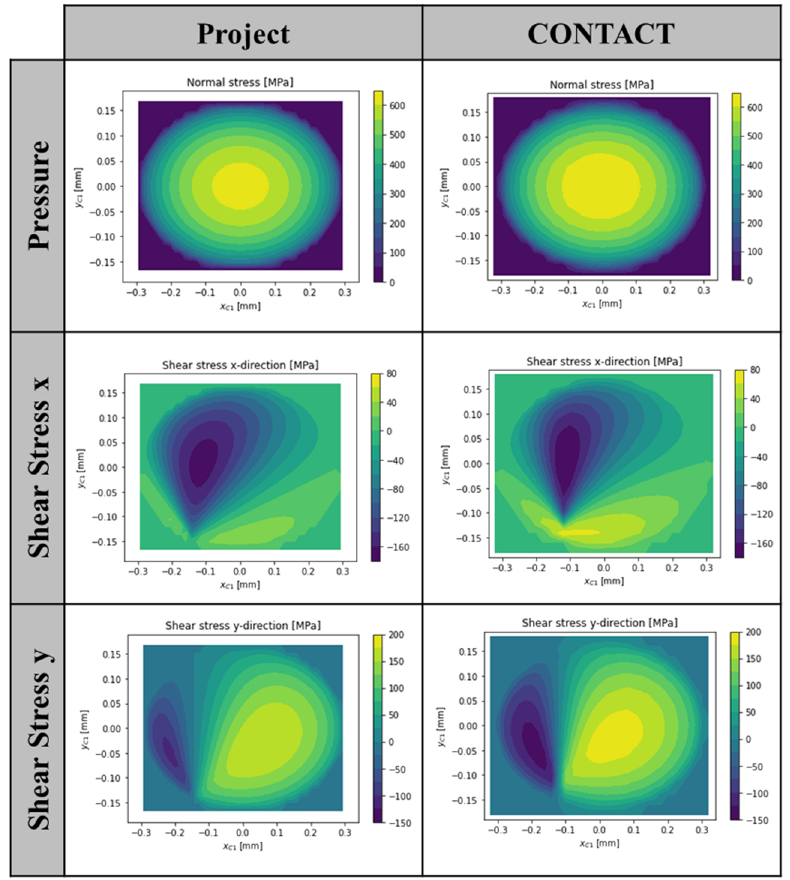
Figure 9. Normal and shear stresses in C coordinate direction; steel/steel, F rad = 200 N, F ax = 30 N, µ = 0.3, driven rolling,